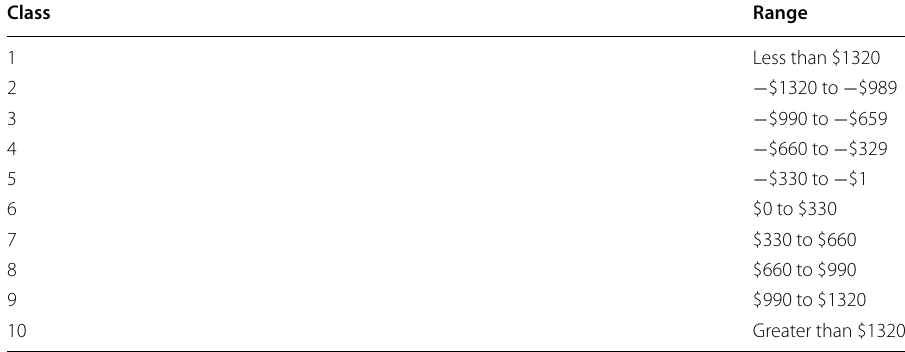
Table 3 Bin ranges for each class